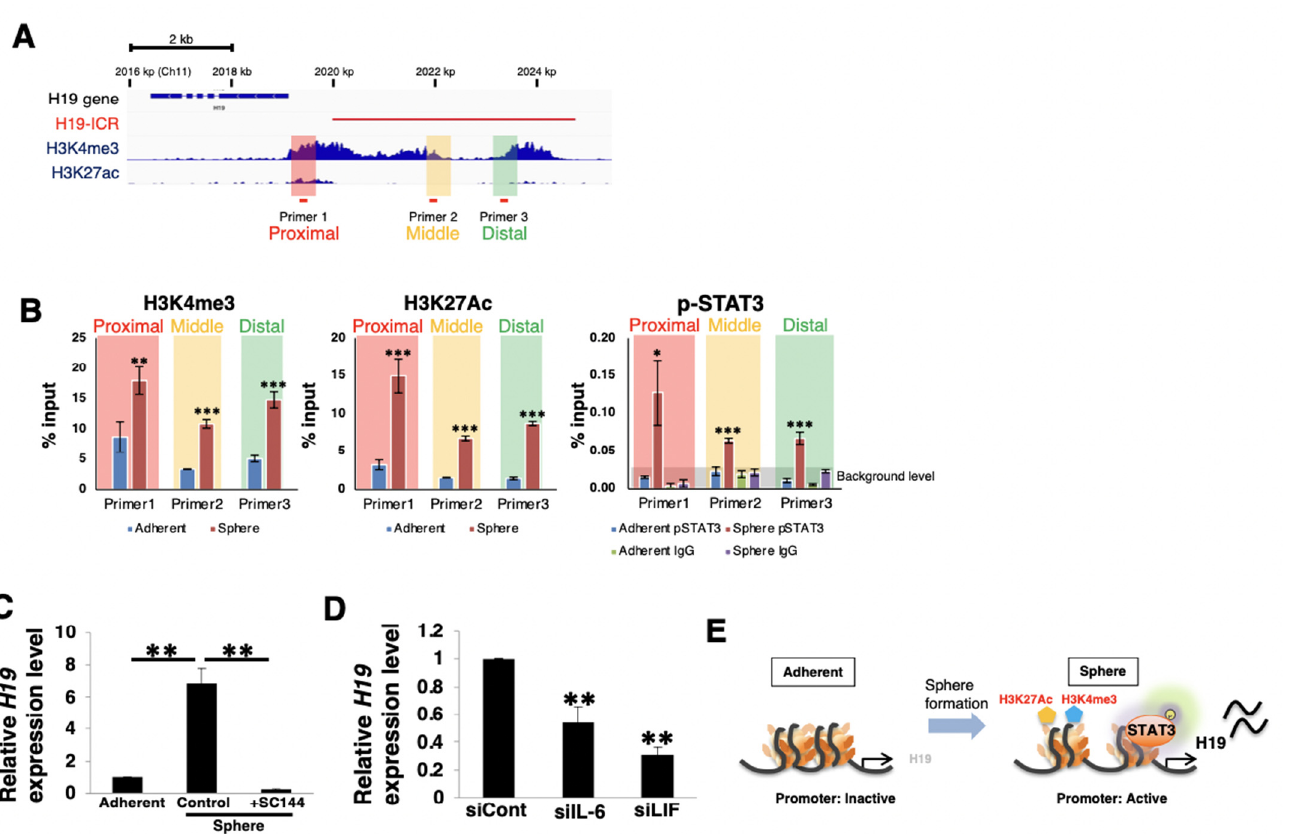
Figure 6. Autocrine/paracrine IL-6 or LIF/gp130/STAT3 pathways regulate H19 expression. ( A ) Schematic representation of the proximal region of the human H19 gene and RNA (human genome: hg19 ch12). Histogram images of H3K27me3 and H3K27Ac in PANC-1 cells were obtained from chromatin immunoprecipitation (ChIP)-atlas (http://chip-atlas.org/, accessed on 18 January 2022). The red line displays the ICR of H19. Three sets of PCR primers designated as Primer 1 (proximal region), Primer 2 (middle region), and Primer 3 (distal region) on the predicted H19 promoter region were used for analysis of ChIP. ( B ) ChIP assays for PANC-1 after sphere formation were performed using anti-H3K27me3, H3K27Ac, and p-STAT3 antibodies and control IgG, and this was followed by real-time qPCR using the designed primer sets specific for the H19 promoter. The data were normalized according to the percent input method. Data are presented as means ± SD from three independent experiments (* p < 0.05, ** p < 0.01, *** p < 0.005 vs. adherent cells). ( C ) Real-time qPCR analysis of H19 in PANC-1 cells cultured for 7 days in 2D (adherent) or 3D (sphere) conditions